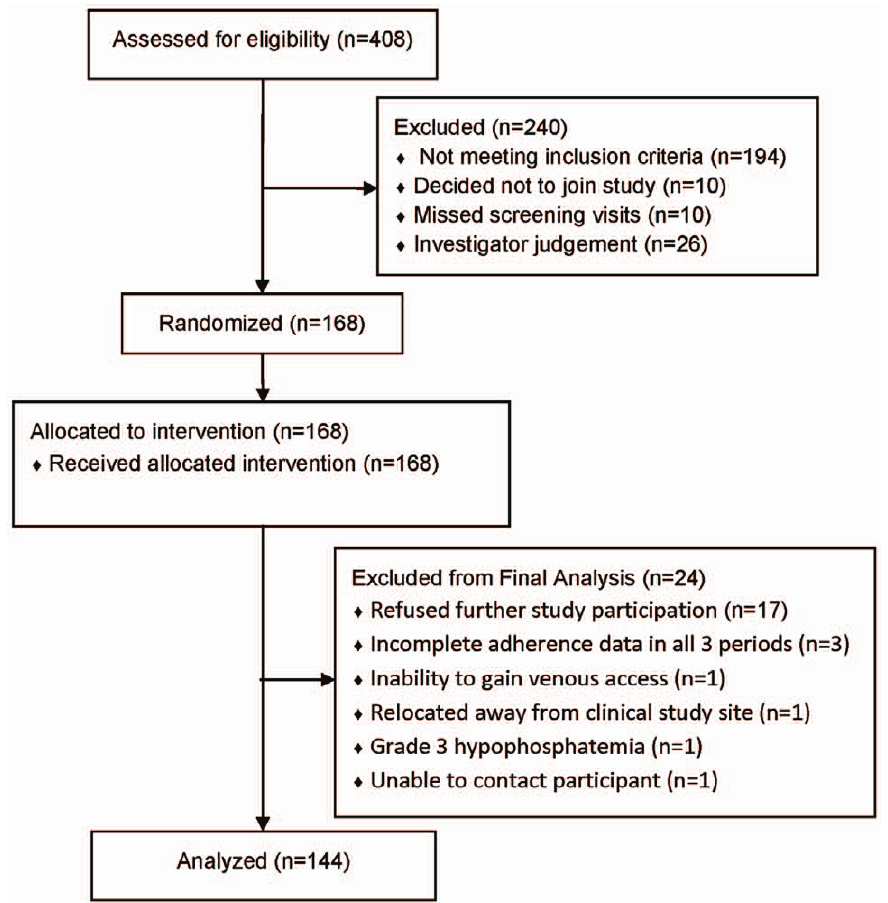
Figure 1. Accounting of research participants from screening to data analysis.